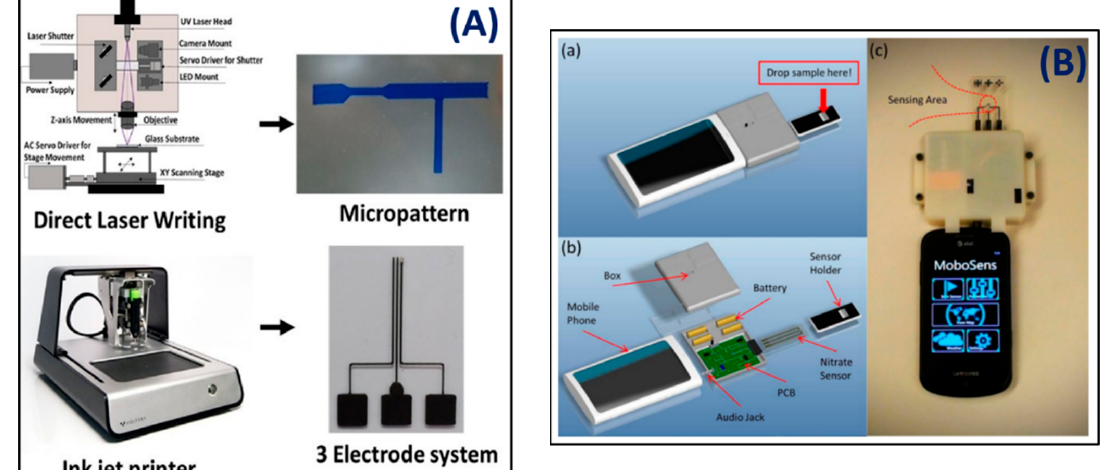
Figure 10. ( A ) Stepwise approach for fabricating a microfluidic device showing the use of a PCB printer to print microelectrodes and three-electrode inset [118]. ( B ) MoboSens has a concept design and a practical package: ( a ) assembly view of MoboSens, ( b ) detailed element description of MoboSens, and ( c ) photograph of the entire MoboSens system [119]. Reprinted with permission of copyright from the respective journals.